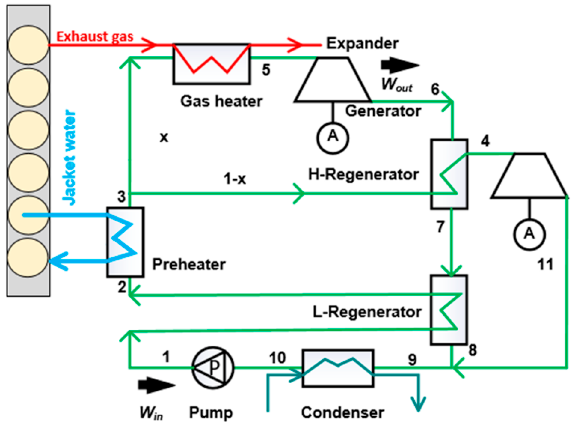
Figure 1. Configuration of the proposed split dual regenerative transcritical Rankine cycle (SR-TRC) coupled with the engine waste heat sources.